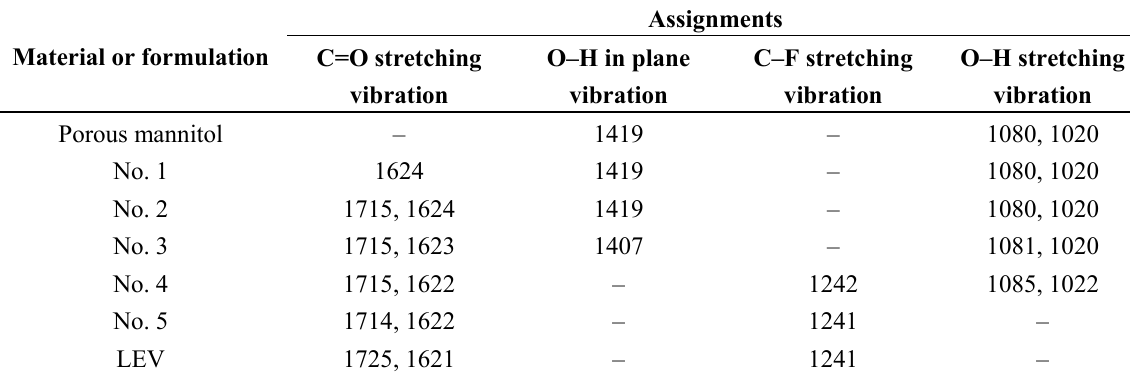
Table 4. Specific characteristics of LEV-proliposomes as compared with porous mannitol and LEV from the IR